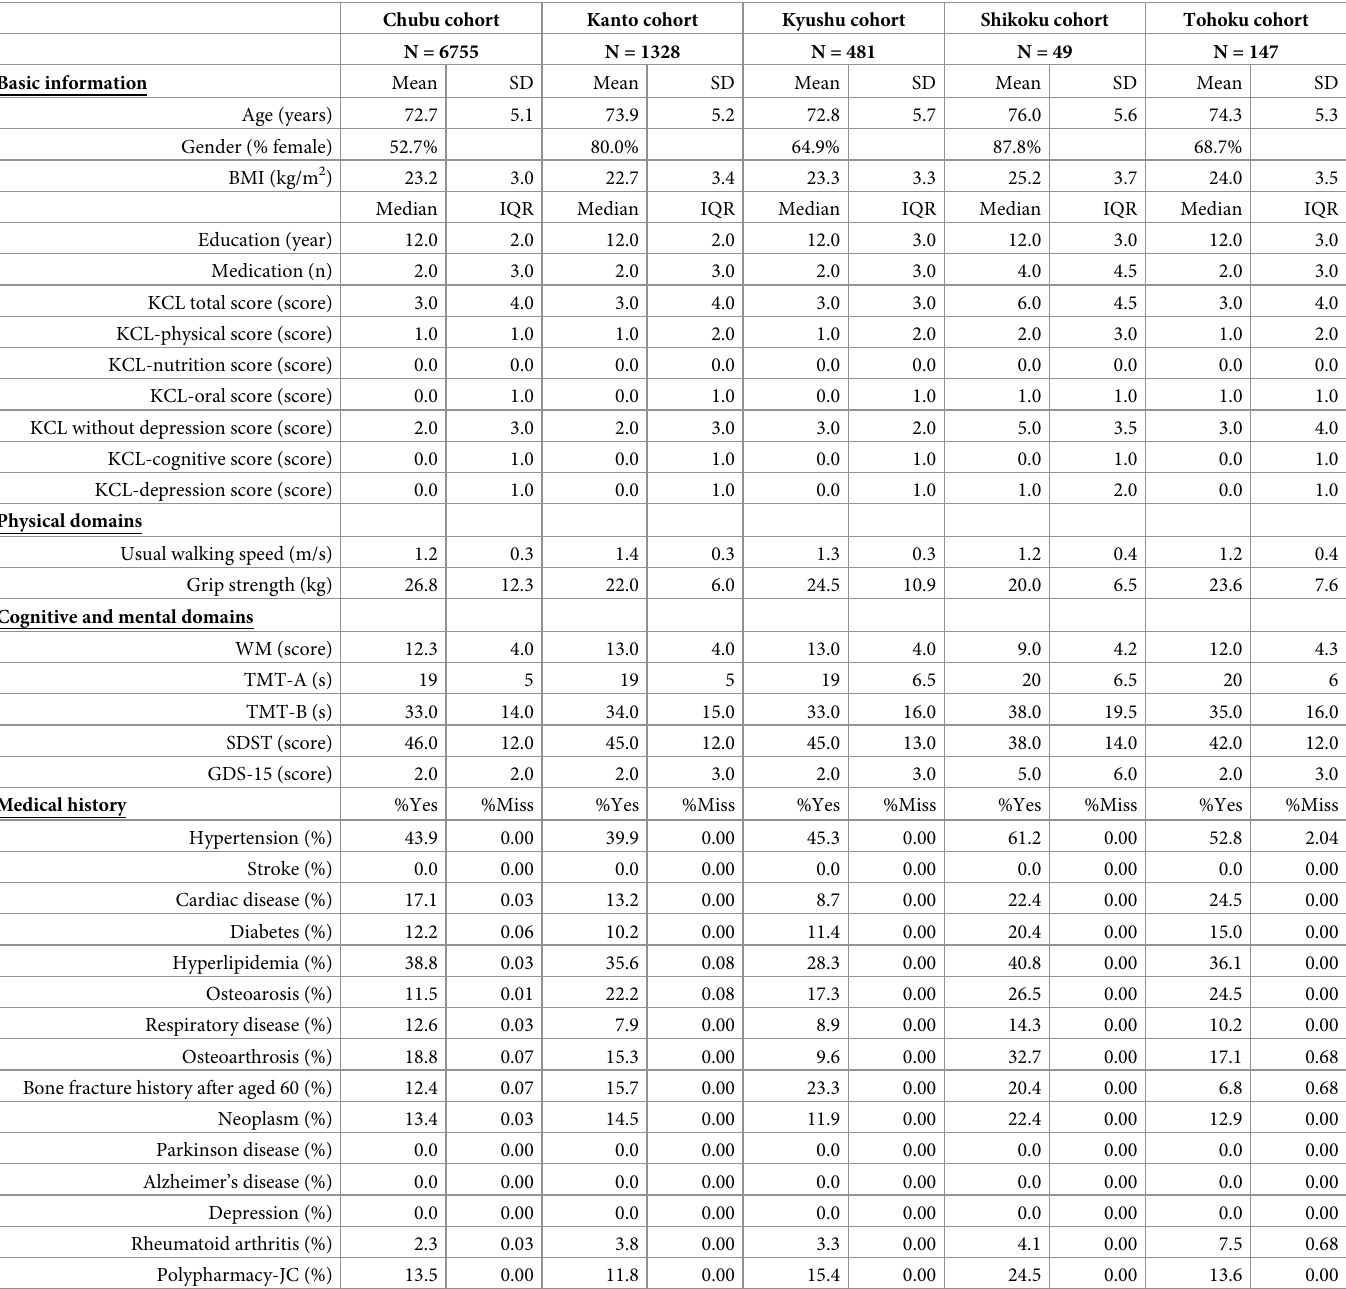
Table 1. Characteristics of participants for each